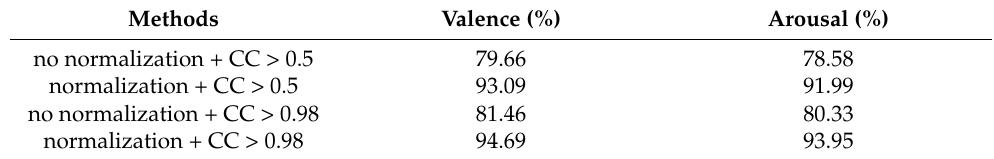
Table 5. Average classification accuracies on all subjects with/without node feature